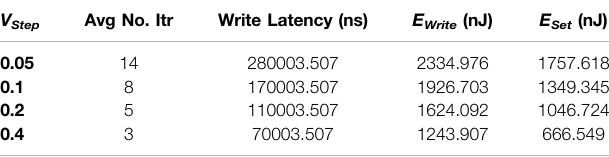
TABLE 3 | The impact of ISPVA settings on latency and energy of the total